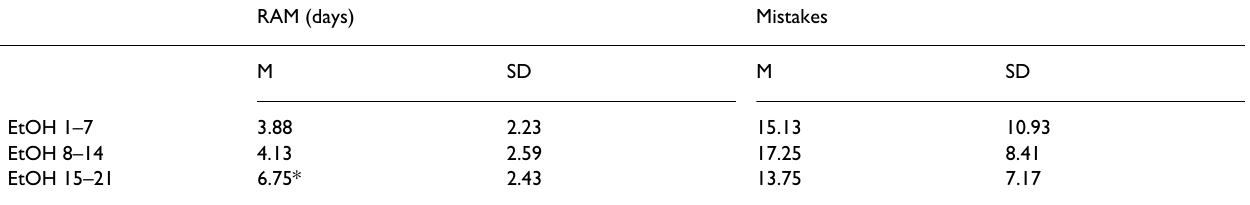
Table 2: Female Data on RAM Performance and Mistakes for EtOH weekly treatment groups. RAM